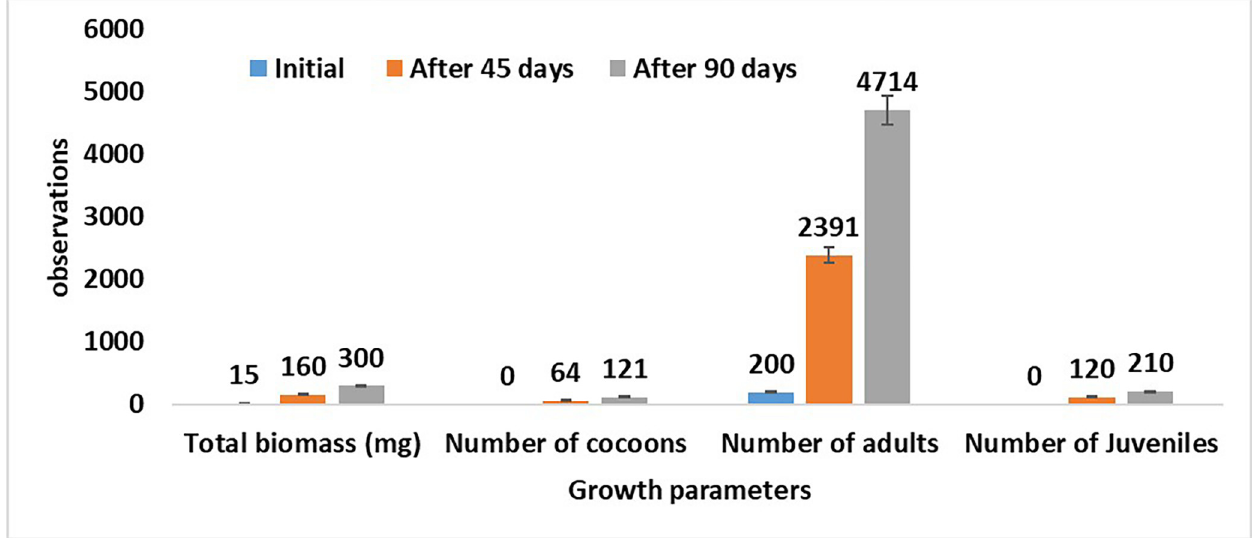
Fig 1. Influence of waste products on E . fetida fecundity and growth of during vermicomposting.